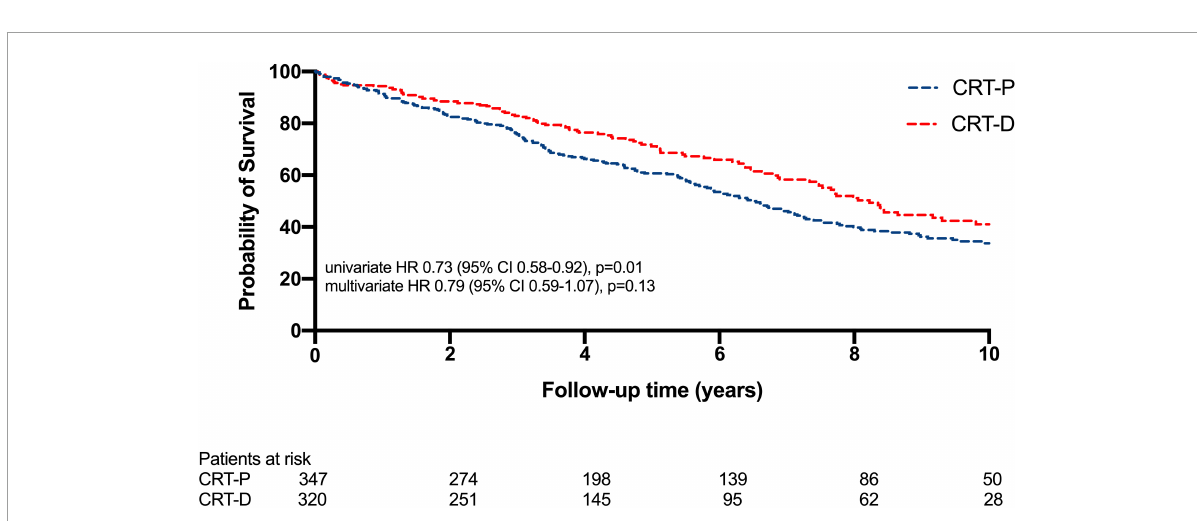
FIGURE2 Kaplan–Meier estimates of survival comparing cardiac resynchronization therapy-defibrillator (CRT-D) and cardiac resynchronization therapy-pacemaker (CRT-P) therapies in non-ischemic patients. In the study population, at long-term a statistically significant benefit can be observed toward CRT-D compared to CRT-P therapy (HR 0.73; 95% CI 0.58–0.92; p = 0.01), yet at multivariate analysis this significance vanished (HR 0.79; 95% CI 0.59–1.07; p =